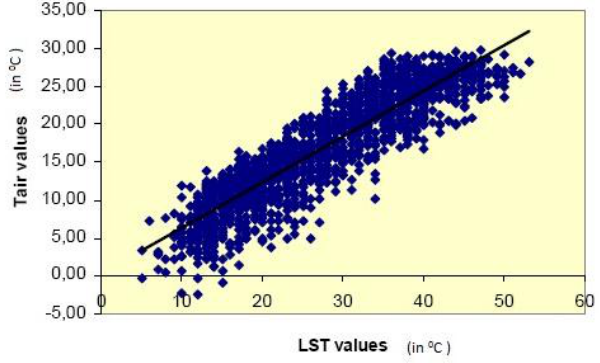
Fig. 2. LST and air temperature (Tair) for Larissa ( ◦ Figure 2. LST and air temperature (Tair) for Larisa ( 0 C). 18